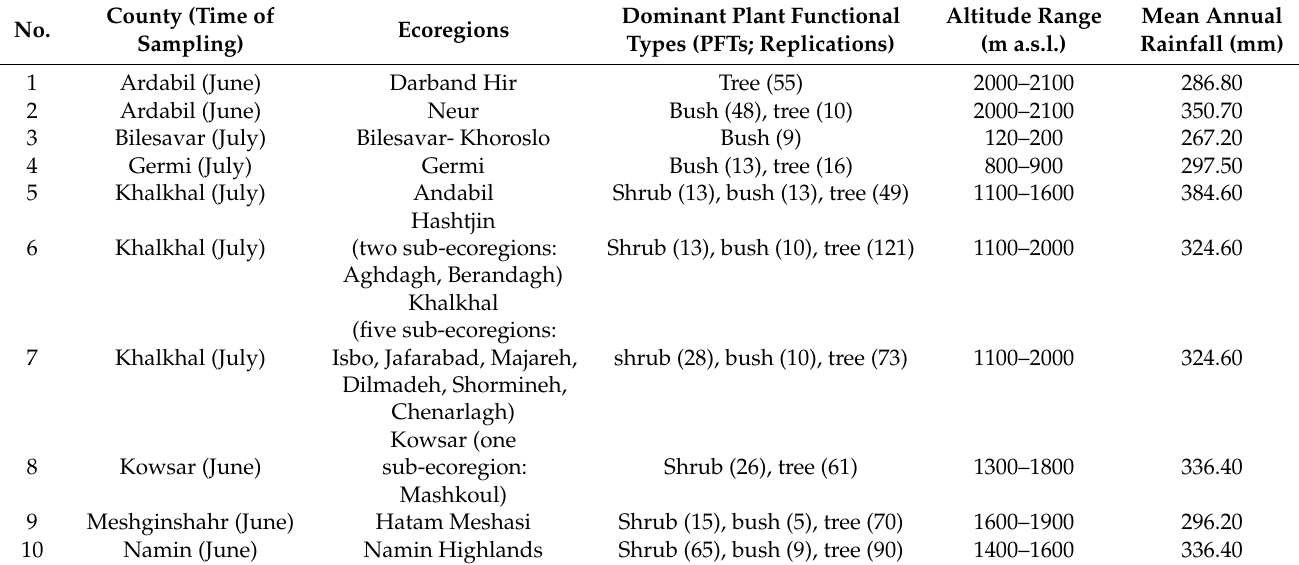
Figure 1. General view from Ardabil Province location, elevation, land cover, and location of synoptic stations [53]. Table 1. General characteristics of the study ecoregions in Ardabil Province.